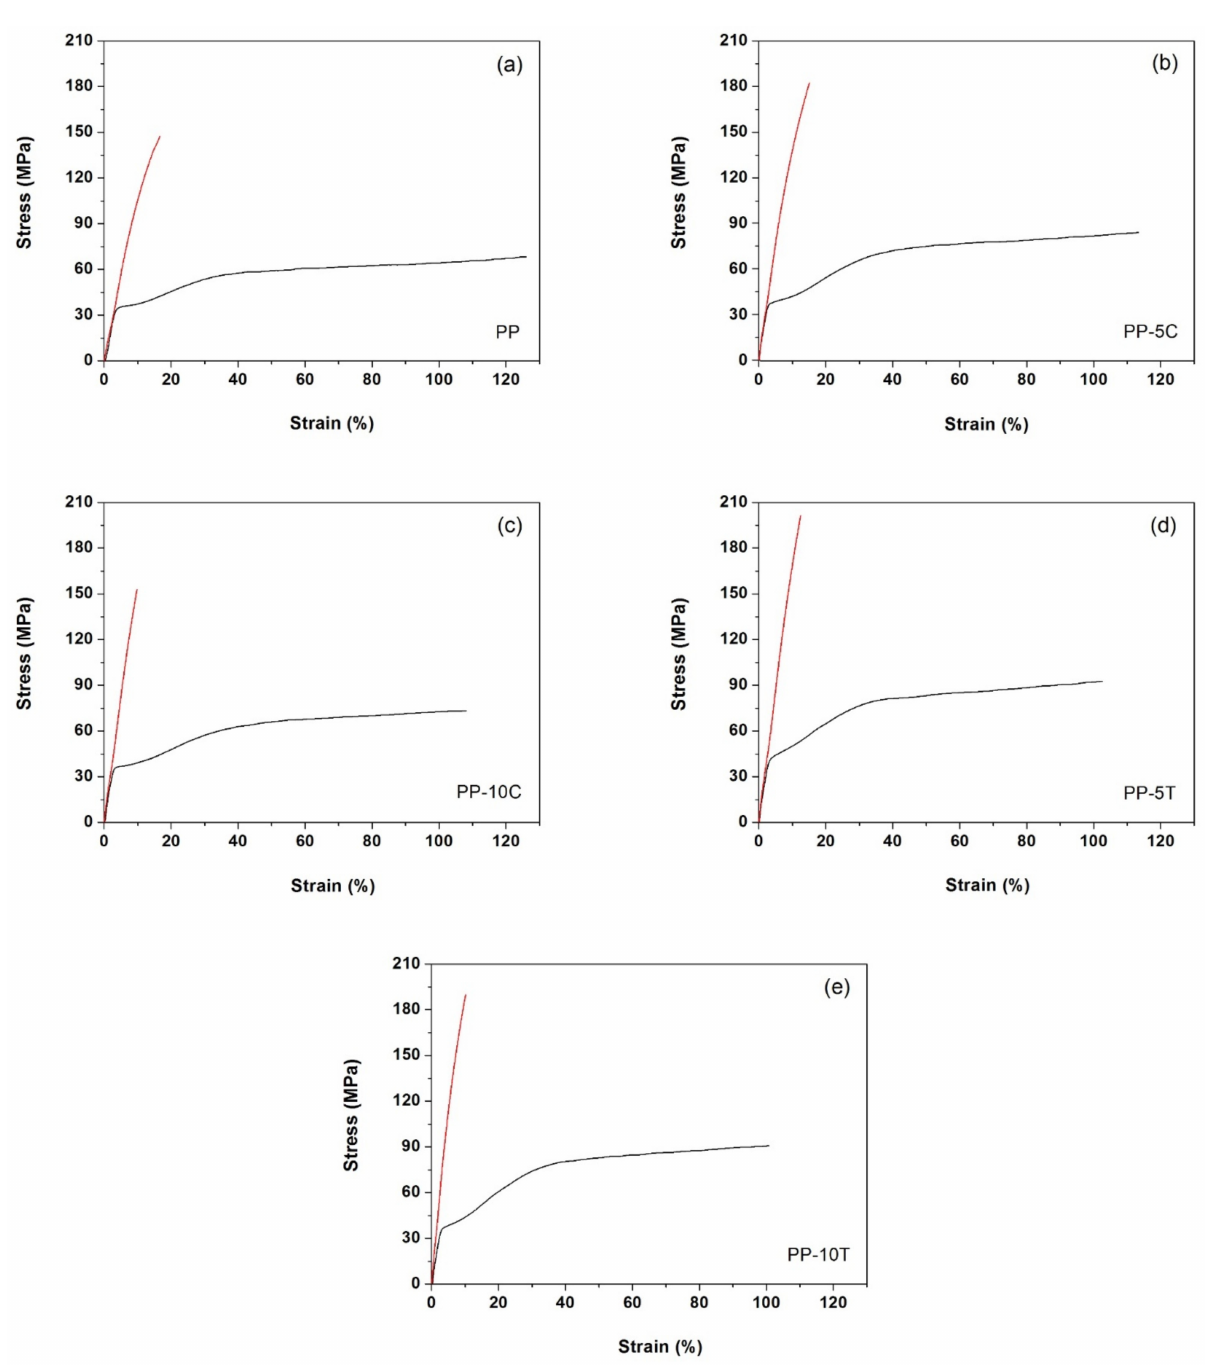
Figure 7. Stress-strain curves of the annealed precursor films (black line) and membranes (red line), with outer layers consisting of: ( a ) Neat polypropylene (PP), ( b ) polypropylene filled with 5 wt% CaCO 3 (PP-5C), ( c ) polypropylene filled with 10 wt% CaCO 3 (PP-10C), ( d ) polypropylene filled with 5 wt% talc (PP-5T), ( e ) polypropylene filled with 10 wt% talc